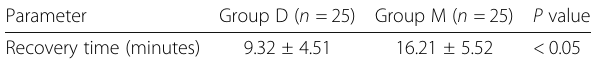
Table 8 Recovery time in the studied groups (data are presented as mean ± SD) Parameter